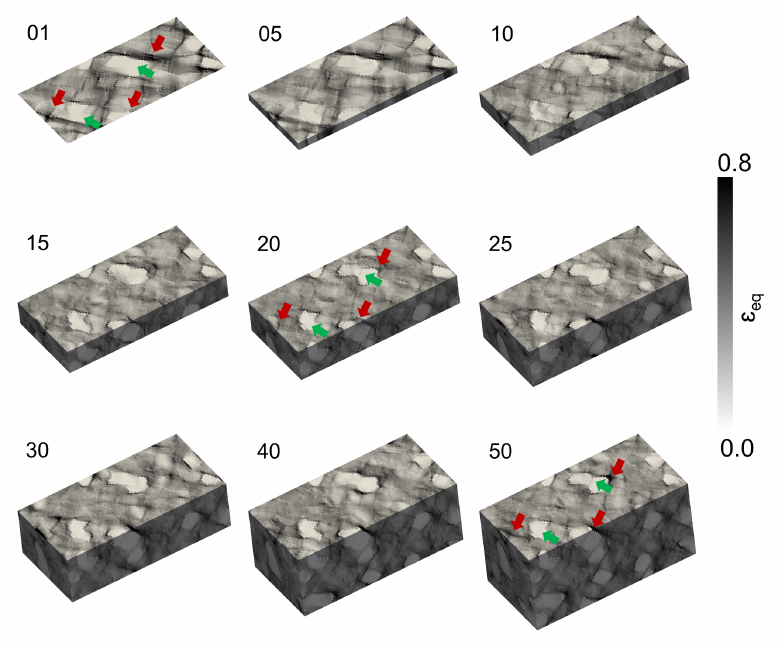
Figure 6. Local von Mises true strain distribution—in ferrite and martensite phases—for all geometries of RVE-E at 25% of global true strain. Red arrows represent areas of high strain in ferrite matrix, and green arrows represent areas of low strain in martensite